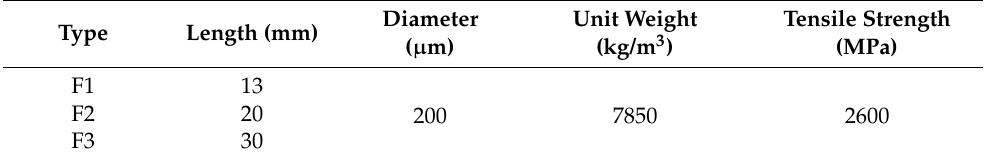
Table 4. Constituent materials of the UHPC (in kg/m 3